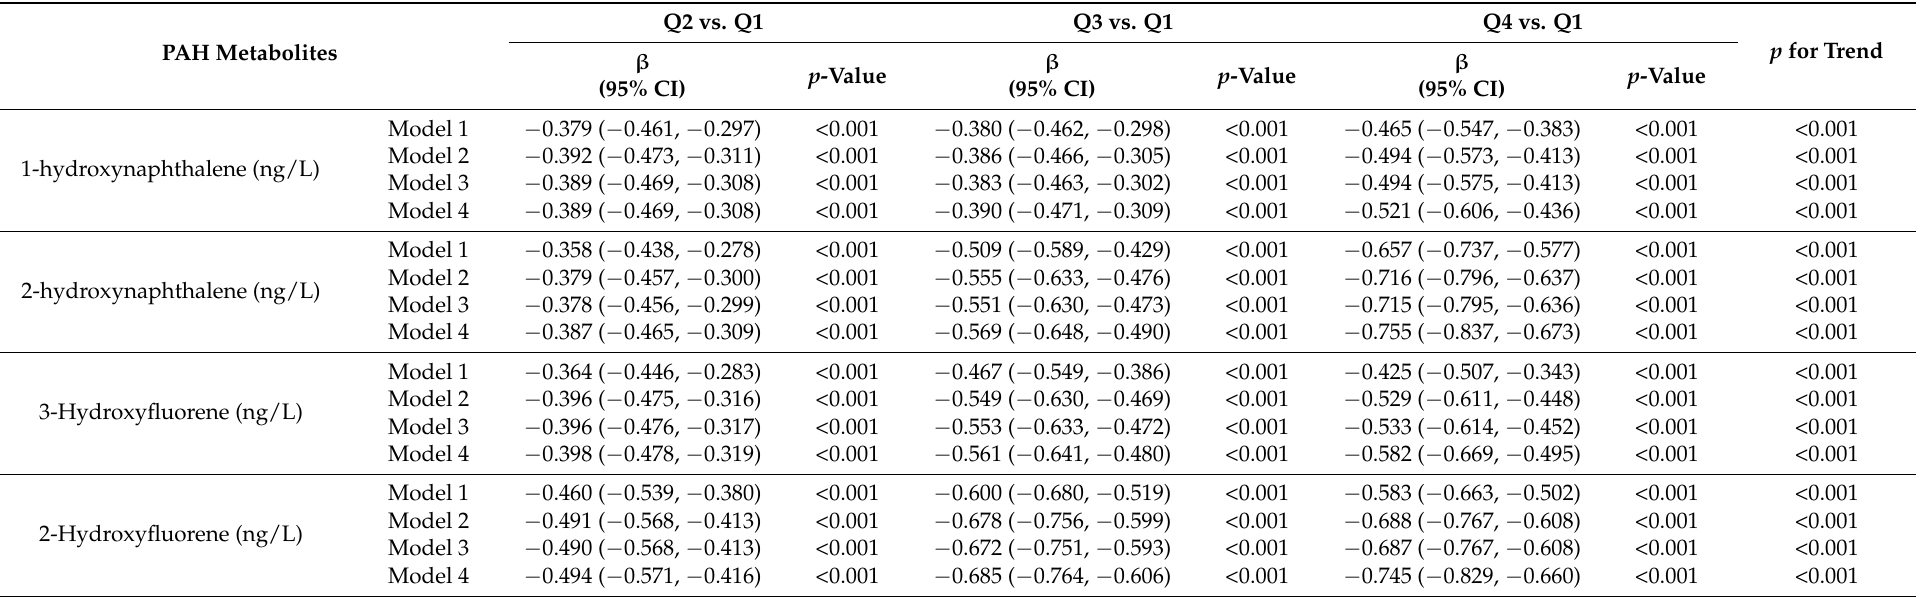
Table 3. Association between quartiles of the PAH metabolites and urine flow